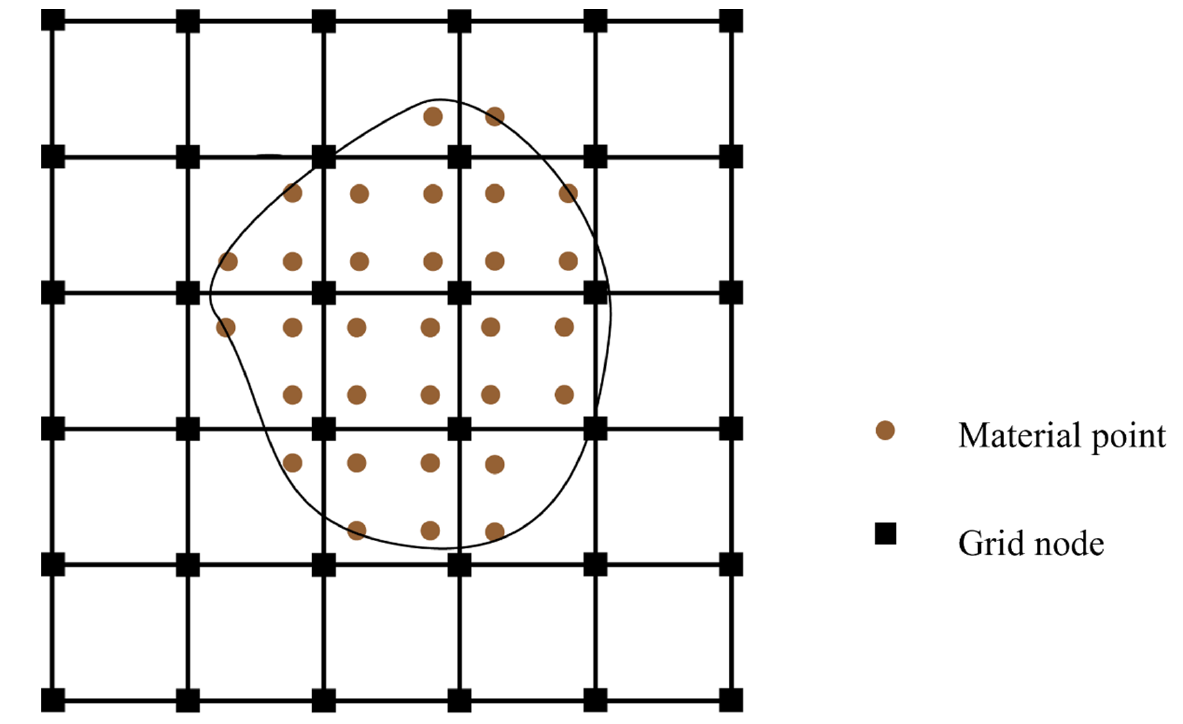
Figure 1. Material point method discrete format.